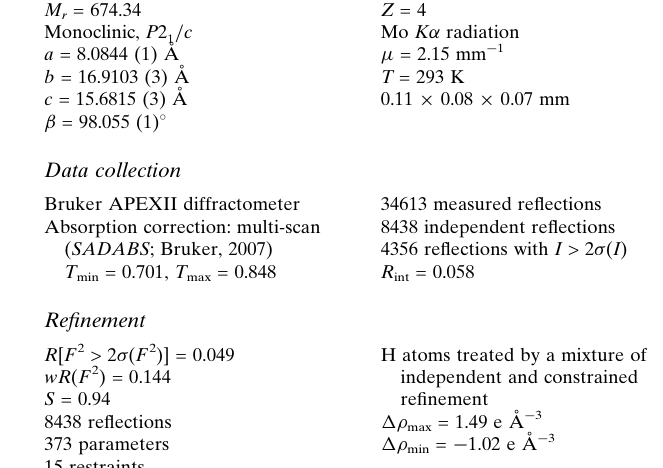
Bruker APEXII diffractometer Absorption correction: multi-scan